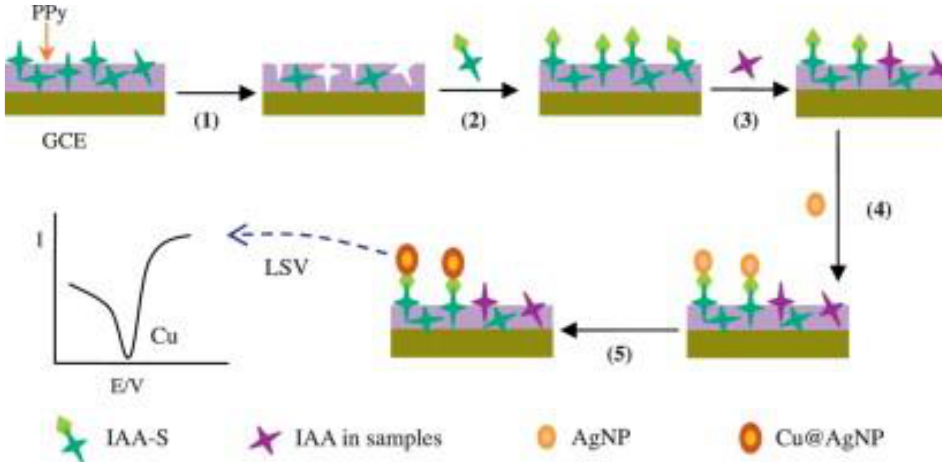
Figure 3. Schematic illustration of nonelectroactive molecular detection. (1) Elution; (2) IAA-S incubation; (3) IAA and labeled IAA-S competition; (4) AgNP labeling; and (5) catalytic copper deposition. Adapted with permission from Ref. [64] . Copyright 2014, Elsevier.